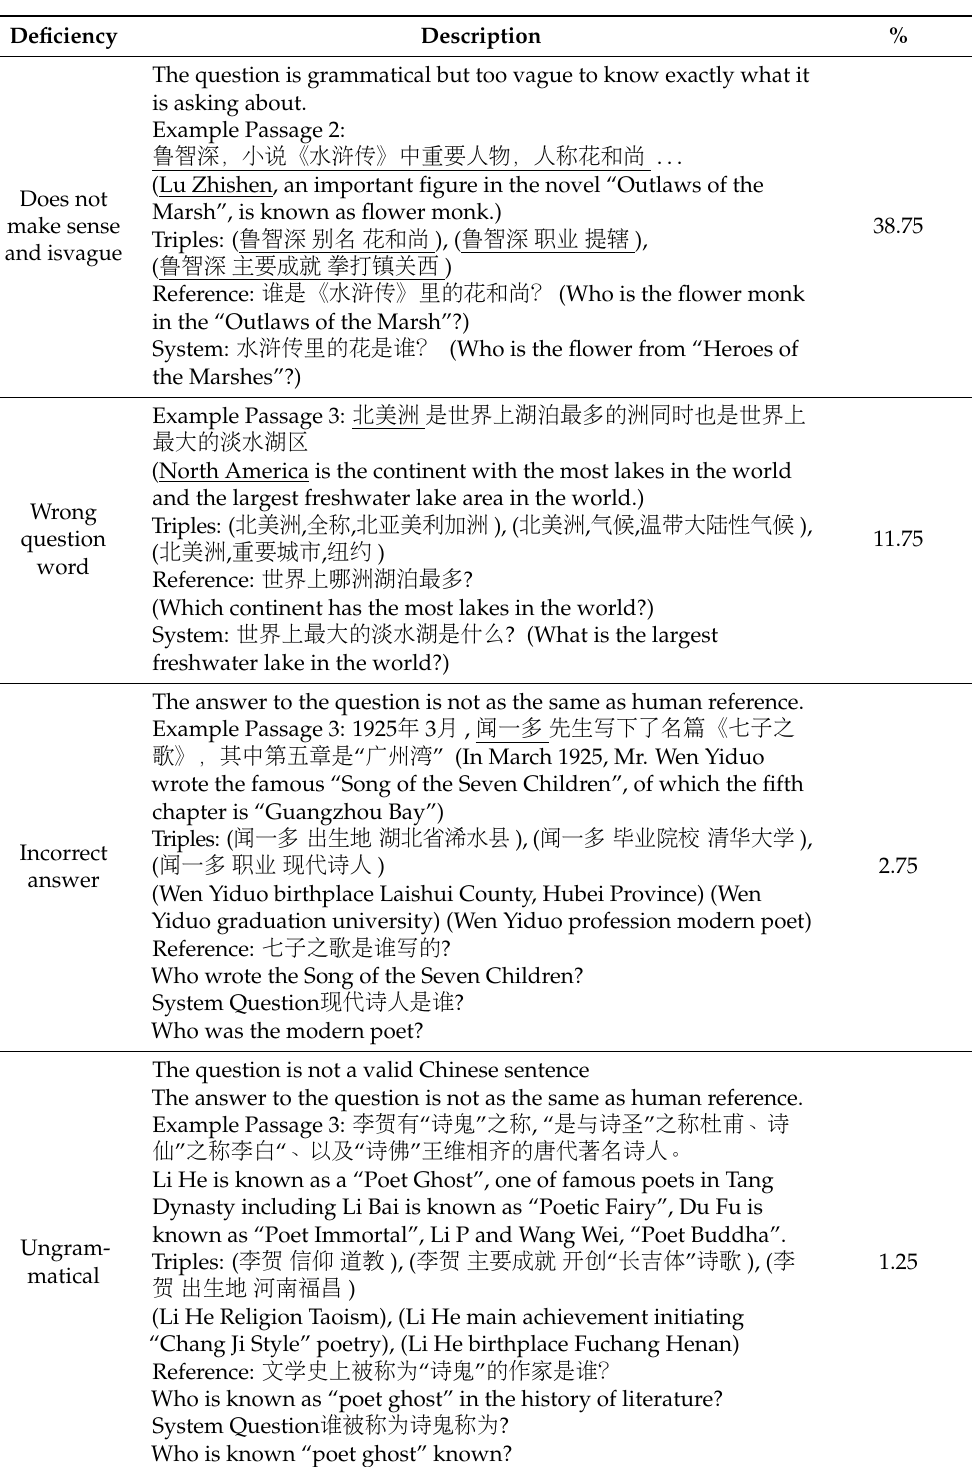
Table 8. Percentage of questions with deficiency generated by Multi-encQG++ model. The passage is compressed, and the target answer is